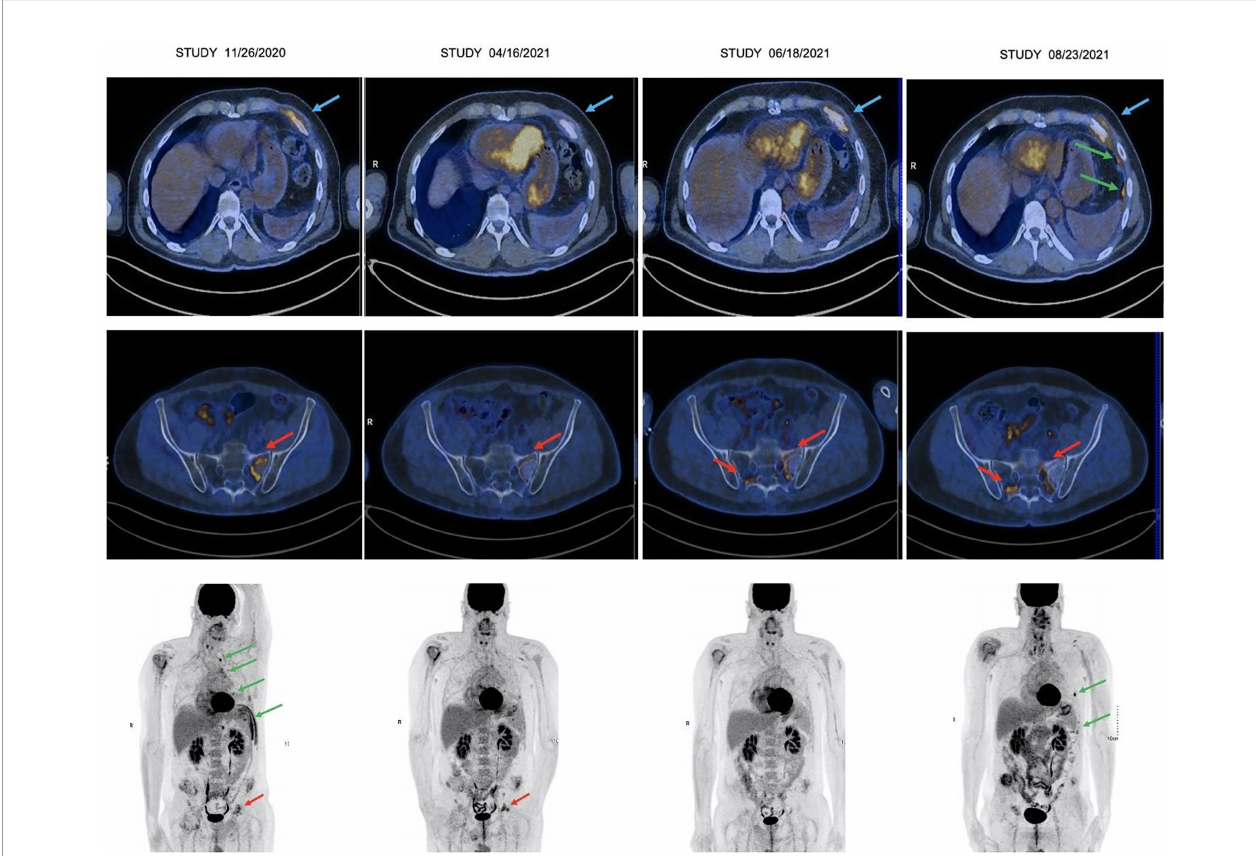
FIGURE 2 | Thoracic (top) and pelvic (middle) transaxial images and whole-body PET/CT (bottom) illustrating the morphometabolic evolution. From left to right on each image: PET/CT 11/26/2020: baseline; PET/CT 04/16/2020: partial response; PET/CT 06/18/2020: maintenance of partial response with very discrete bone progression; PET/CT 08/23/2020: left pleural, soft tissues and bone morphometabolic progression. Blue arrows: soft tissue involvement; greens arrows: pleura involvement; red arrows: bone